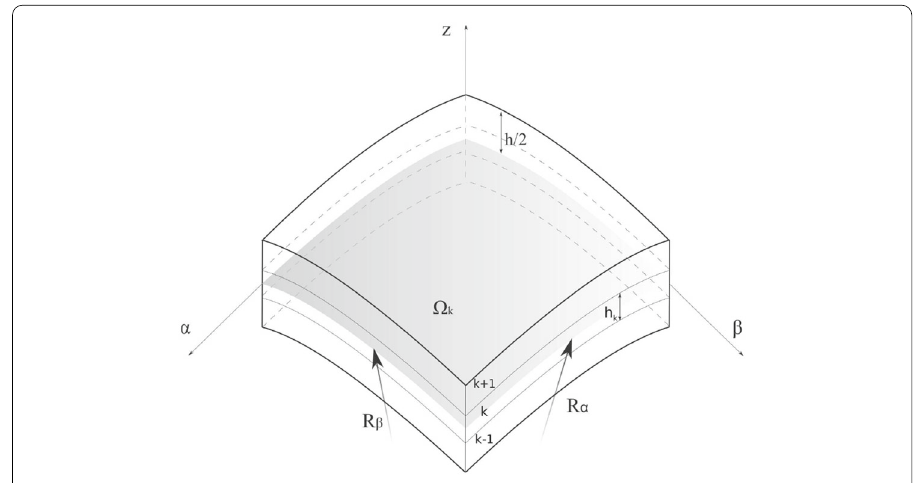
Fig. 1 Notation of a shell model for laminated